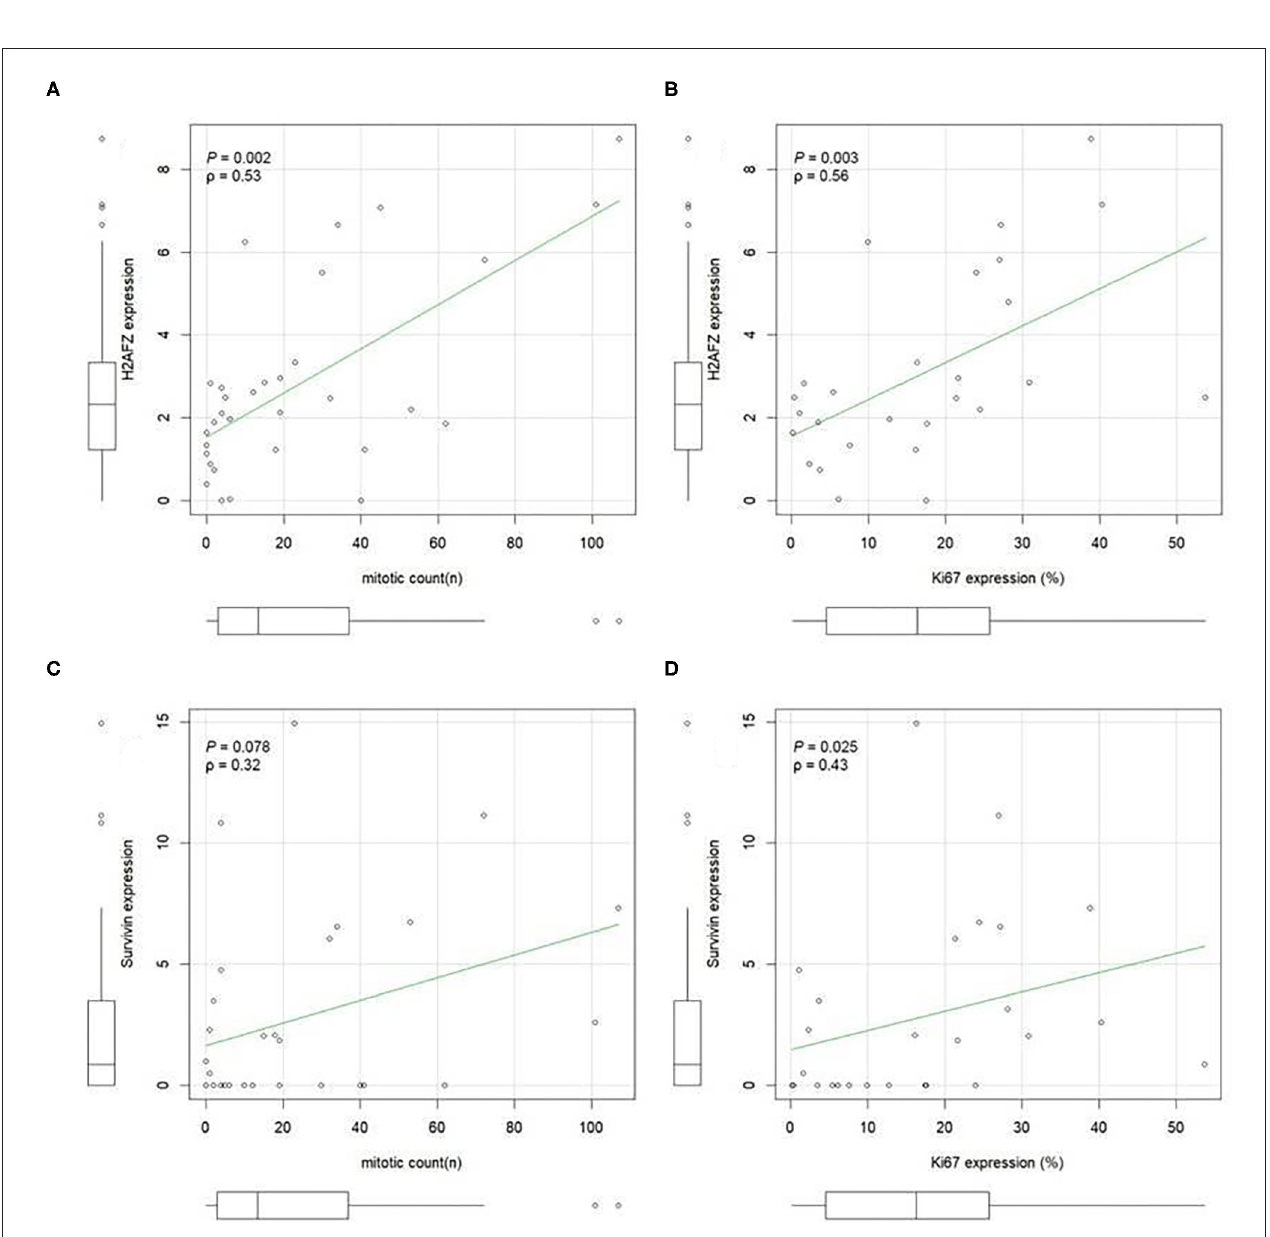
FIGURE 4 | H2AFZ and survivin/BIRC5 mRNA expressions in tumor tissue correlate with histological proliferation markers. A positive correlation was evident between H2AFZ (A) , but not survivin/BIRC5 (C) , expression levels and mitotic count (MI); while both gene expression levels positively correlated with Ki67 index (B,D) . Spearman correlation coefficient. Ki67 was calculated as the number of positive cells on the total number of counted cells (mean 1,090 cells, ranging from 900 to 1,376 cells) using Image J analysis system.